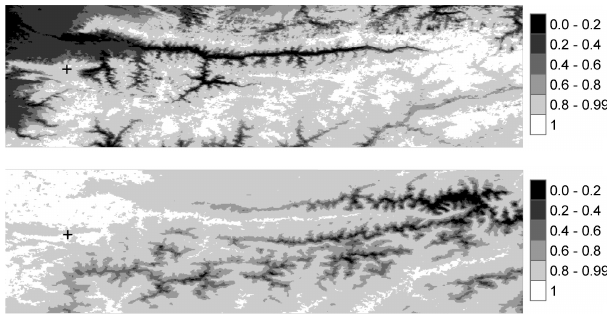
Figure 6. CP maps for snow (top) and land (bottom) conditions for the pixel x = 100, y = 100 (black cross) with elevation 2206ma.s.l.